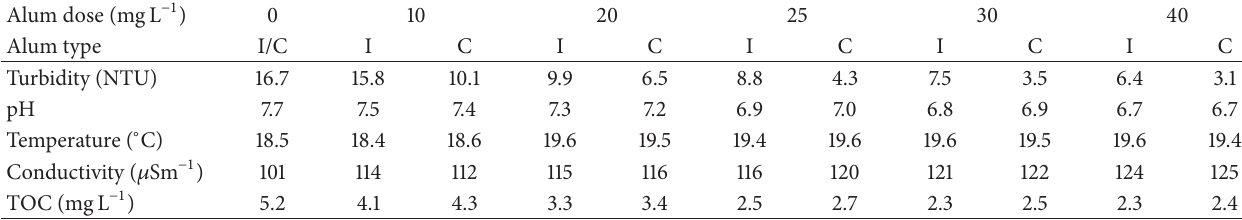
Table 4: Coagulation tests using commercial and local